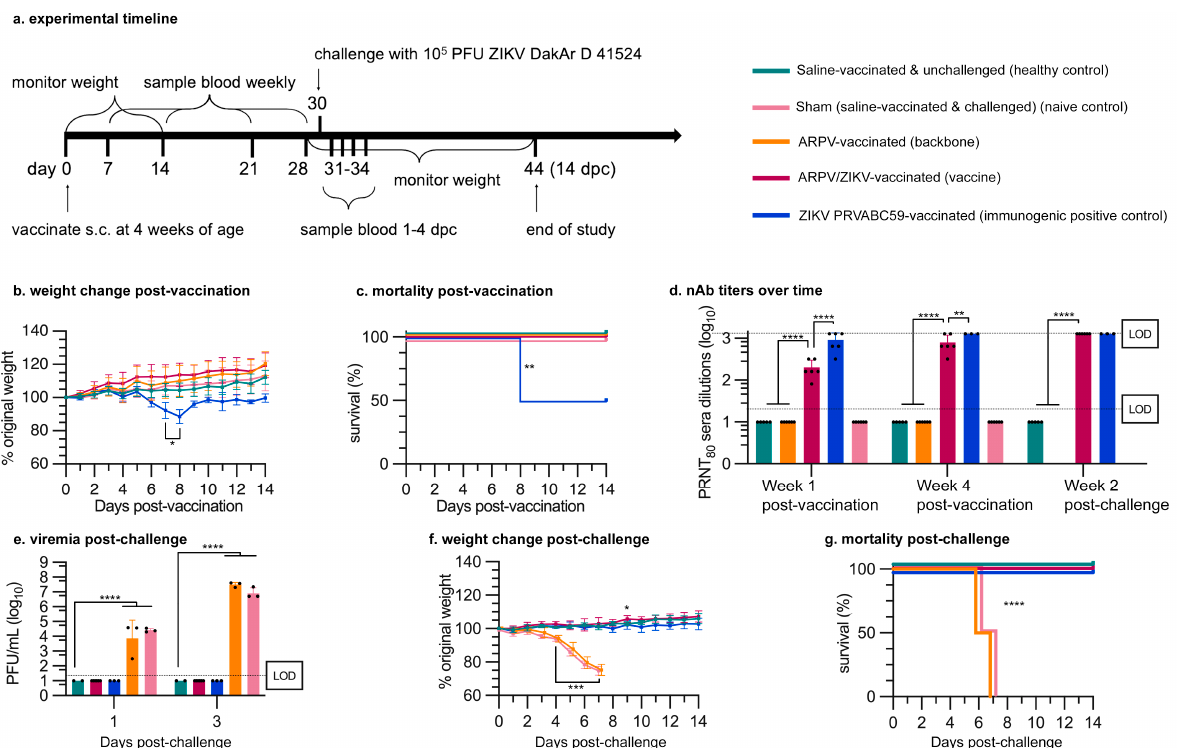
Figure 4. Single-dose ARPV/ZIKV vaccination was safe and provided complete protection against lethal ZIKV challenge in IFN- αβ R -/- mice. Four-week old IFN- αβ R -/- mice (n = 6) were immunized s.c. at day 0 post-vaccination. Vaccination